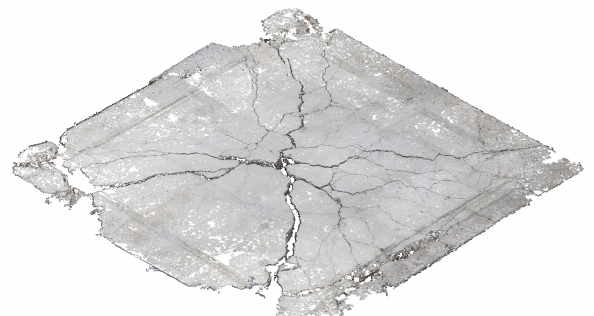
Figure 3. Point cloud of plate in sun with S8 camera.